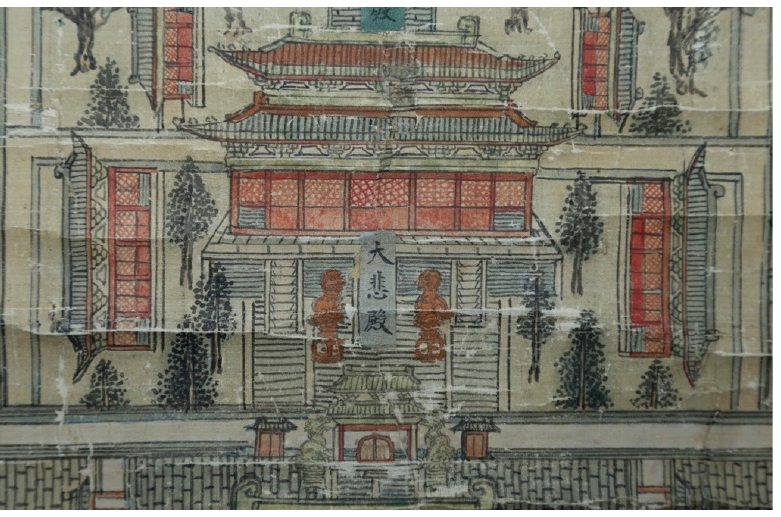
Figure 5. The Great Compassion Hall in the Plan of Chongshansi (photo by author, 25 November 2020).